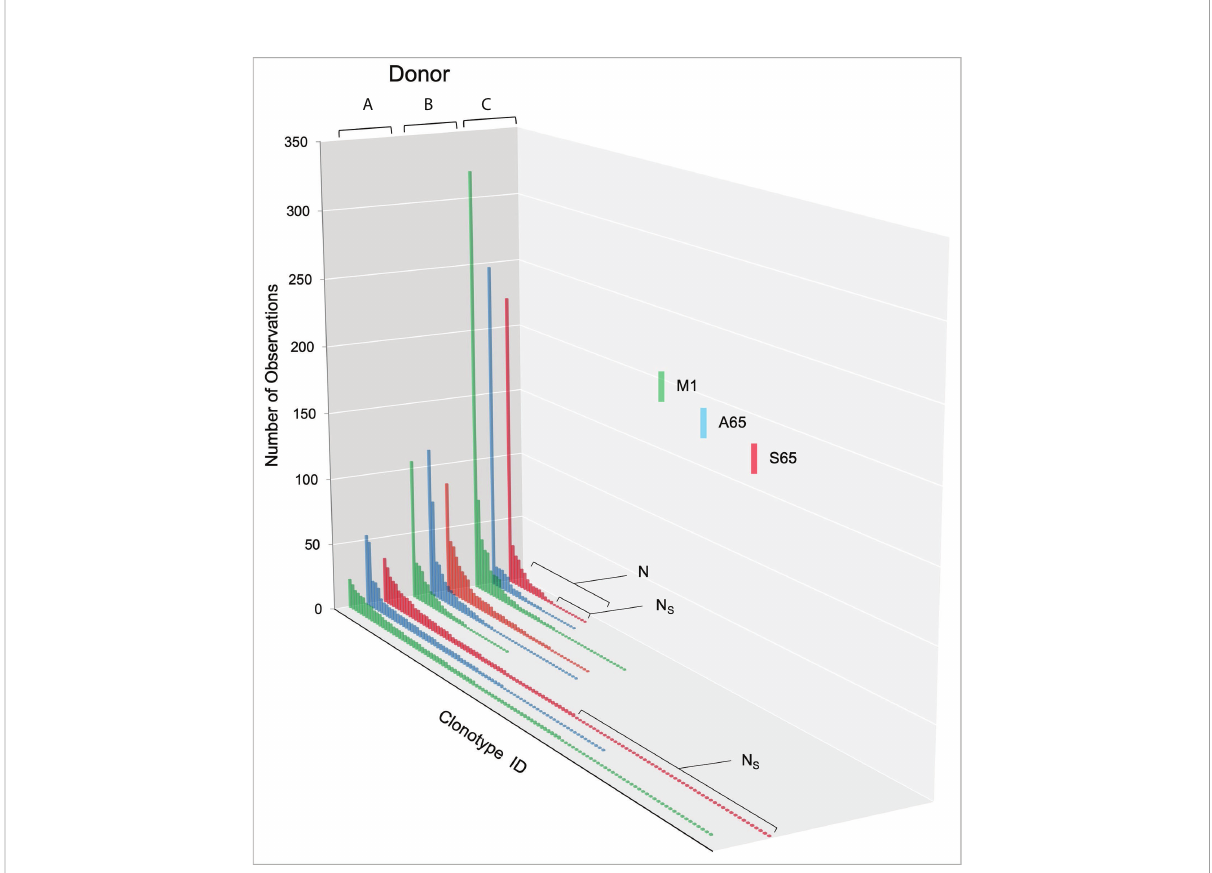
FIGURE 1 Distribution of clonotypes in M1, A65 and S65 peptide repertoires for three donors. Donors A, B and C are identi fi ed above each clonotype distribution, and peptides are identi fi ed by color as shown in the legend. Clonotype frequencies are plotted in descending order and shown on the y-axis. Clonotype IDs for each donor are on the z-axis and omitted for simplicity. N – the number of clonotypes in a repertoire; Ns – the number of singletons. The repertoire characteristic values are provided in Table 1.